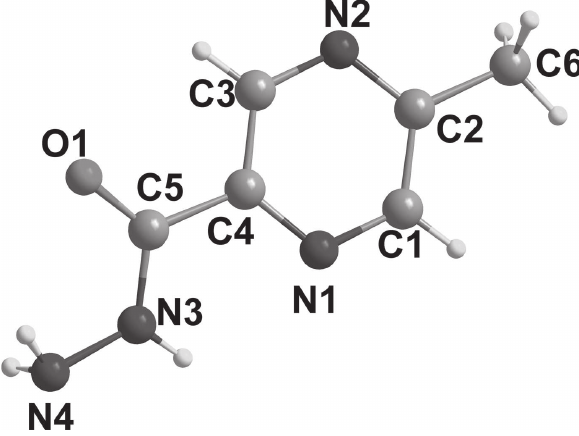
Table 1: Data collection and handling.